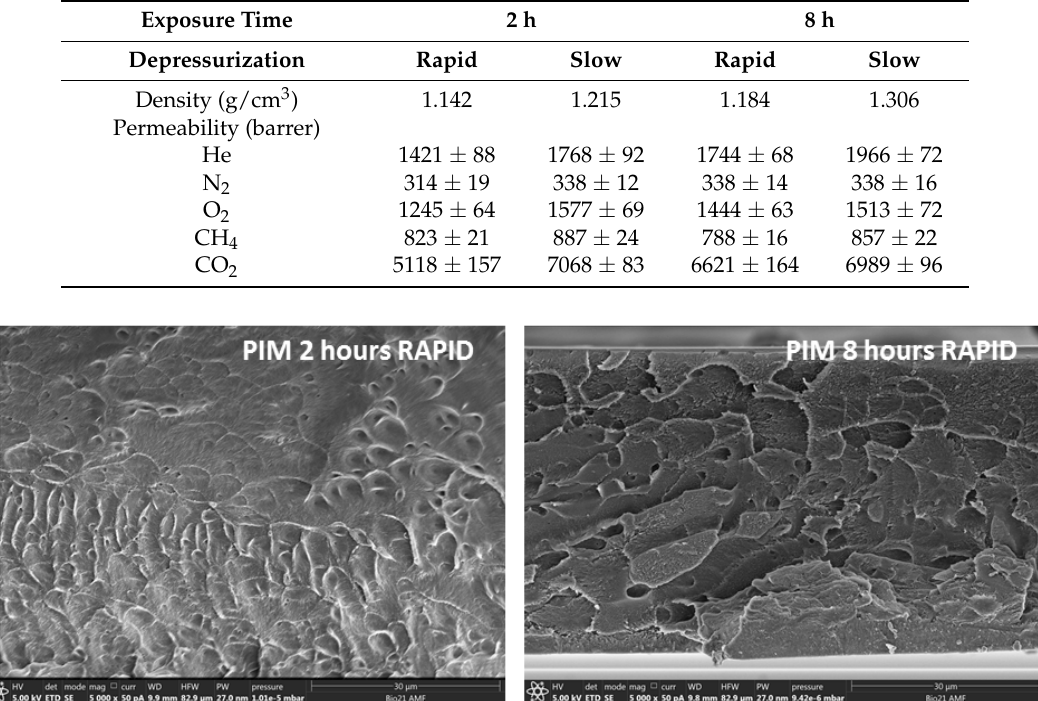
Figure 2. Scanning electron microscope (SEM) images of the PIM-1 membranes after two- and eight-h exposure to scCO 2 , with rapid depressurization. Table 4. Density (g/cm 3 ) and gas permeability (barrer) in supercritical CO 2 -treated PIM-1 membrane